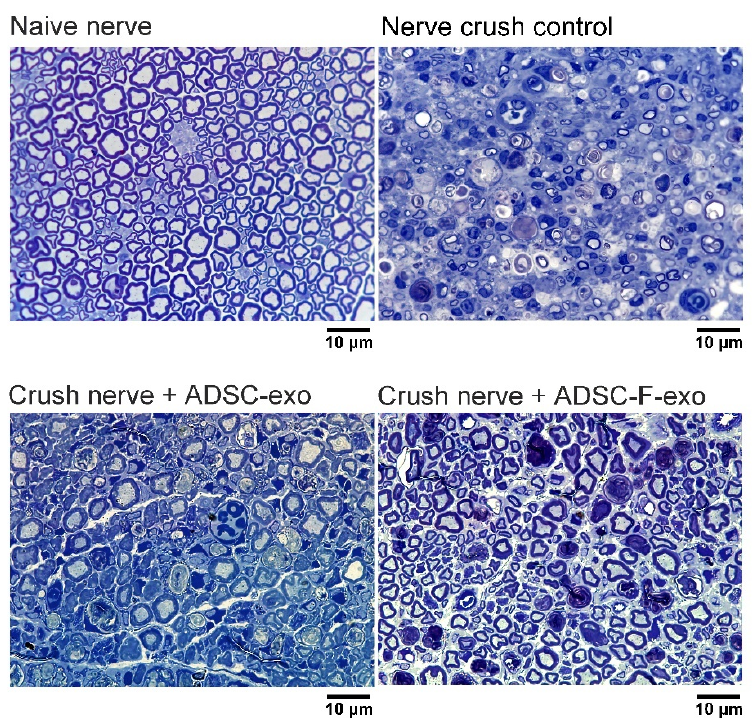
Figure 2. Histomorphology of toluidine blue-stained nerve specimens, harvested 5-mm distal to the injured site in C57BL/6 mice on post-crush day 10. Representative histological sections (×1000) stained with toluidine blue. The magnification bars represent 10 μ m. ADSC-exo, exosomes secreted by adipose-derived stem cells (ADSCs). ADSC-F-exo, exosomes secreted by ADSCs following FK506 stimulation. Table 1. Quantitative histomorphometric analysis of toluidine blue-stained nerve specimens, harvested 5-mm distal to the injured site in C57BL/6 mice on post-crush day 10.